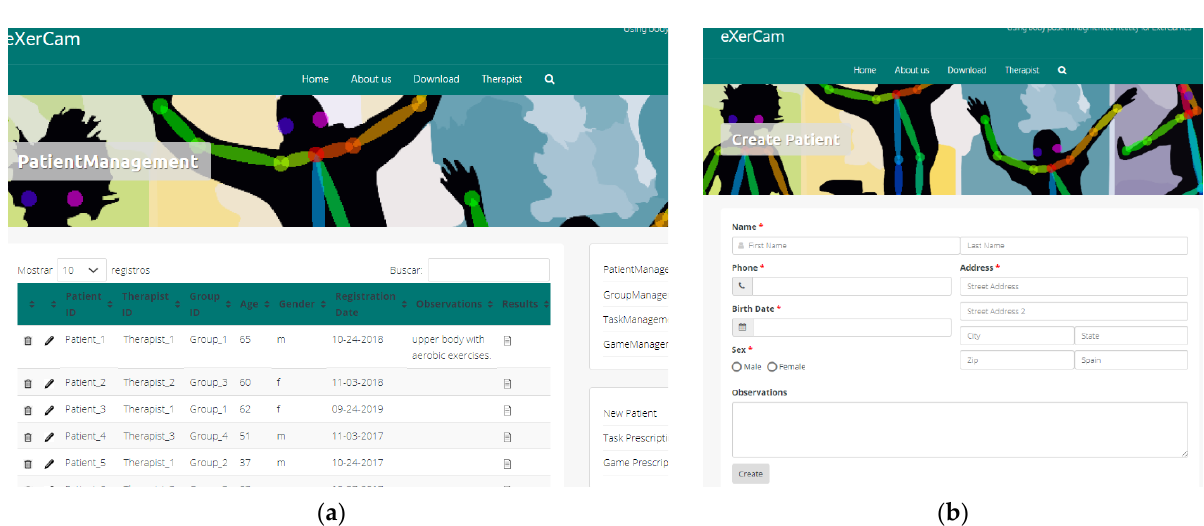
Figure 7. Patient Management. ( a ) Main page of the Patient Management section. ( b ) Form for creating a new patient.